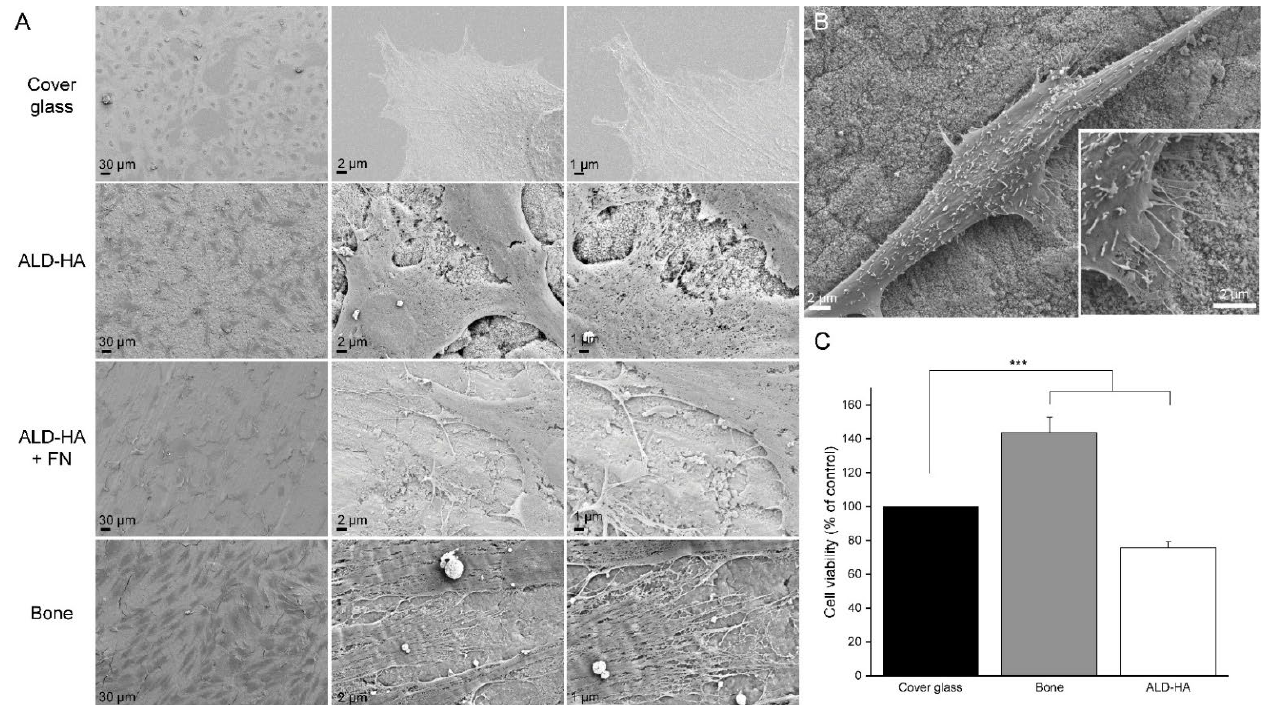
Figure 1. Morphology and viability of MC3T3-cells on cover glass, ALD-HA and bone. ( A ) FESEM images of MC3T3 cells cultured on cover glass, ALD-HA, FN-coated ALD-HA and bone (representative data from one culture). The cells were cultured for 48 h. The samples were evenly covered with cells, and the cells seemed to attach to the surface with focal adhesion-like structures. Magnification: 150× (left panel), 2500× (center panel) and 5000× (right panel). ( B ) Morphology of one MC3T3 cell cultured on ALD-HA. Magnification 2500×. ( C ) MTT test results of MC3T3 cells cultured on cover glass, bone slices and ALD-HA. MTT test was performed after 48 h cell culture on the samples. Cell viability on bone slices and ALD-HA samples was compared to cover glasses, which were treated as controls by setting their viability to 100%. The data is pooled from three independent cell cultures and shown as mean ± SEM. *** p <0.001.